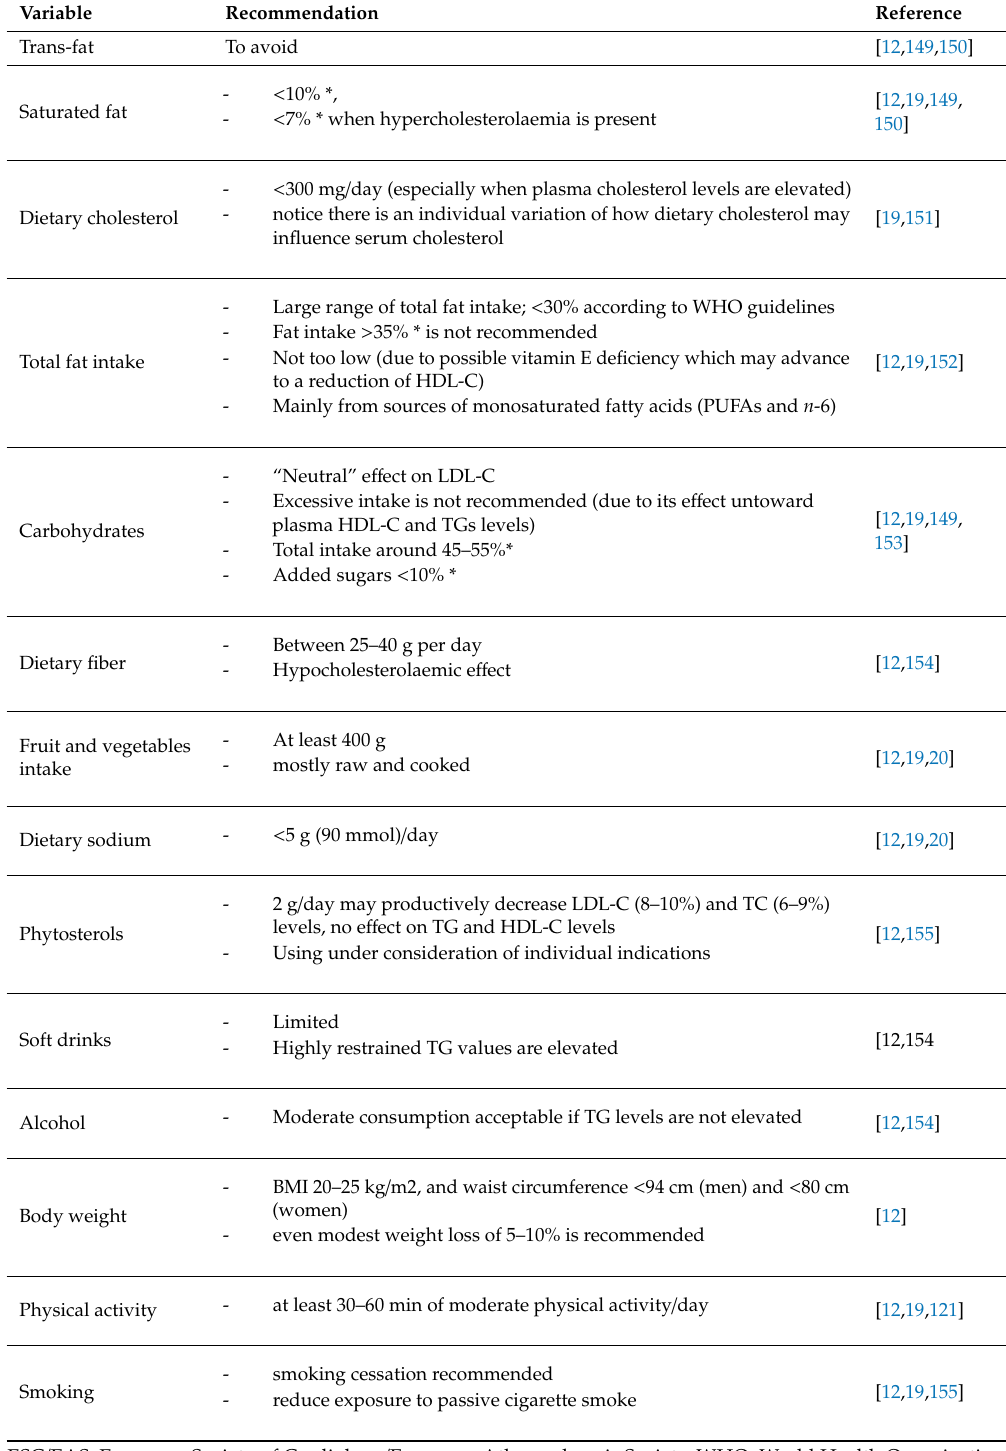
Table 4. ESC / EAS and WHO nutritional and behavioral recommendations in